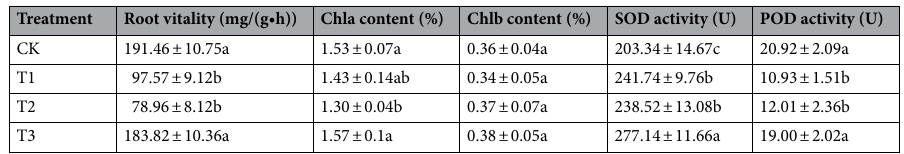
Table 5. The effects of different treatments on root vitality, chlorophyll content and protective enzymes’ activities of tobacco. *T1, the CK group inoculating R. solanacearum 1–1; T2, the T1 group adding mixed PAs; T3, the T2 group adding combined PAs-degrading bacteria. Different letters indicate significant difference ( P < 0.05) according to Duncan’s multiple range test.